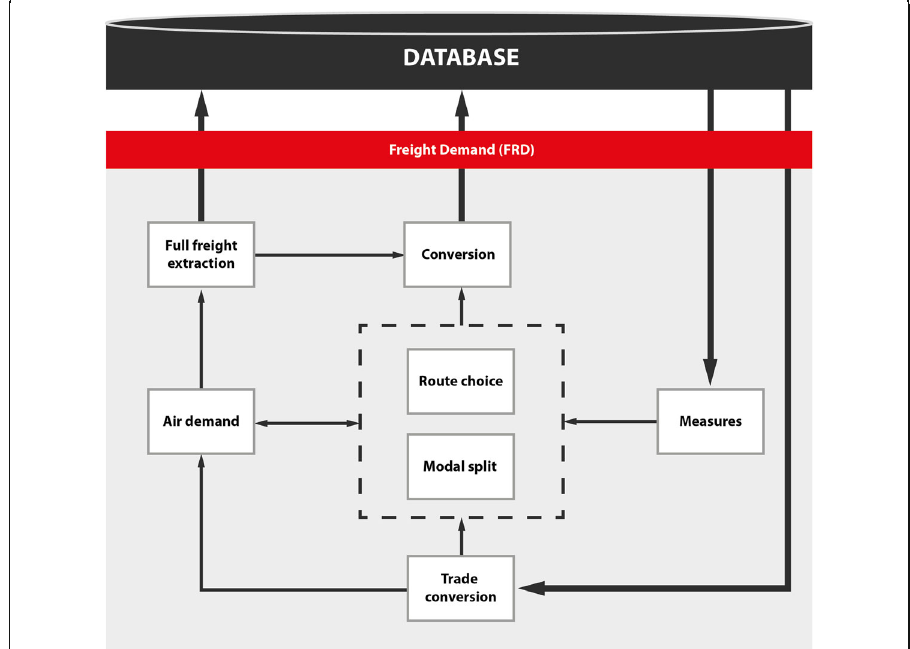
Fig. 6 Structure of the Freight Demand